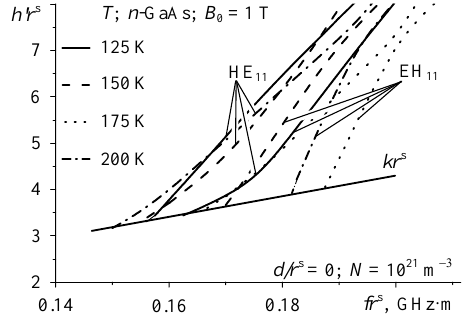
Fig. 10. Wave phase characteristics of models of gyroelectric n -GaAs semiconductor waveguides, when d/r s = 0; B 0 = 1 T; N = 10 21 m 3 .